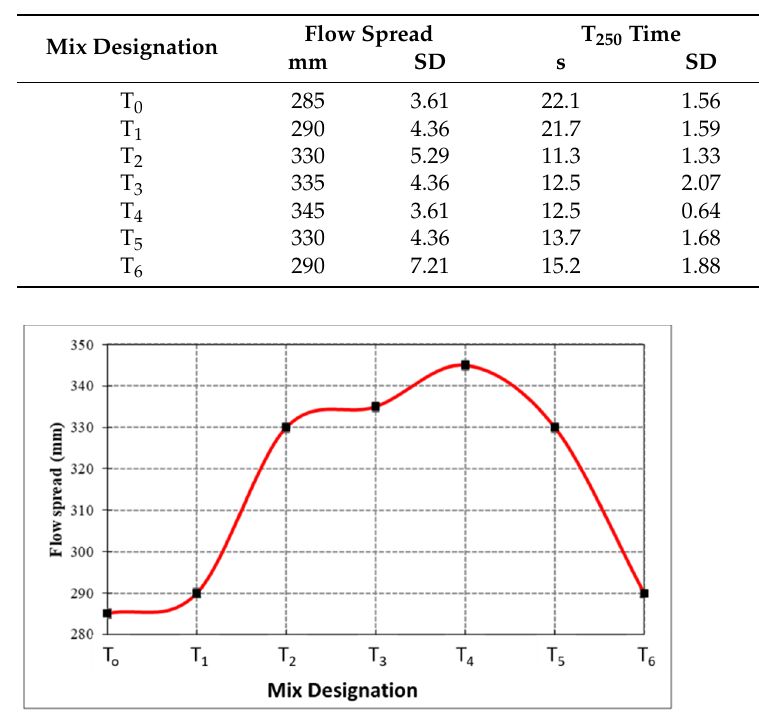
Figure 3. Relationship of V-funnel time with T 25 with varying silica fume content .